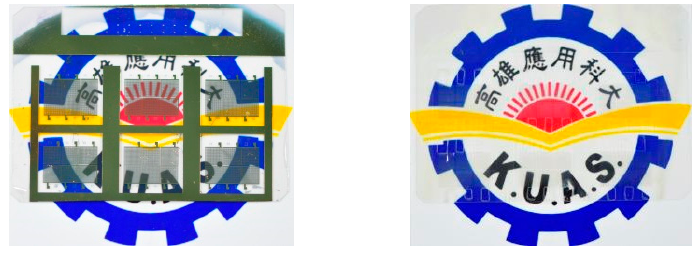
Figure 7. CMUTs with gold ( left ) and silver nanowire ( right ) top electrodes.